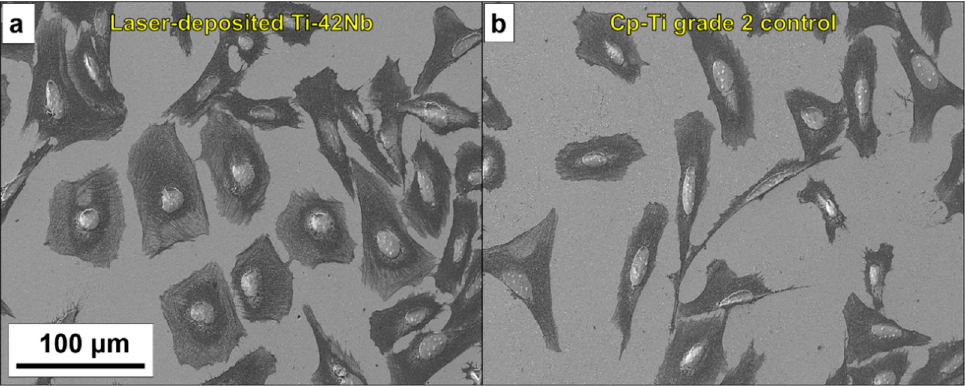
Figure 13. Micrographs showing cell adhesion: ( a ) laser-deposited Ti-42Nb, and ( b ) cp-Ti grade 2.